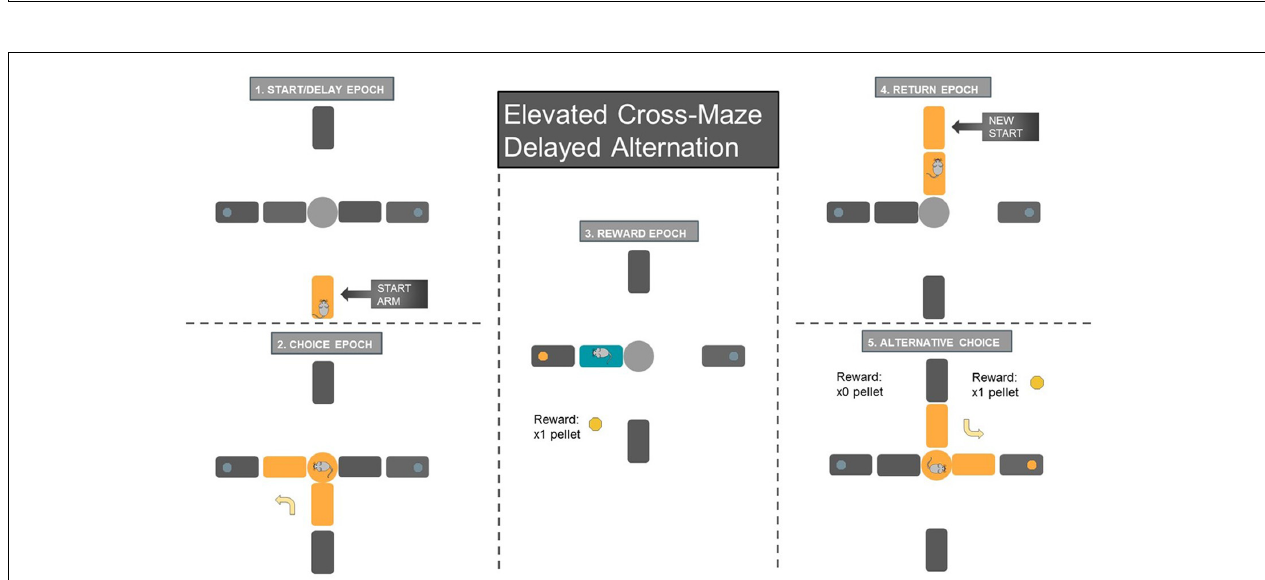
FIGURE 2 | Schematic of Delayed-Alternation Task. (1) Animals waited on the start arm for 10 s during the start/delay epoch. The arm segment closest to the center platform was lowered to confine the animal to the start arm region for the delay period. (2) The choice epoch started when the animal entered the center platform of the maze and made a choice to the left/right reward arm. The blue circle at the end of each reward arm signifies the metal cup where sugar pellets were delivered through food dispensers upon the animal’s arrival. (3) The reward epoch, which was analyzed only for the rewarded choice, while the other reward or start arm was lowered. Animals consumed the sugar pellet once they obtained the reward at the metal cup. (4) The return epoch began when the animal finished reward consumption and returned to the recently raised start arm (start arm location was pseudorandomized over the 60 choice trials). (5) Once the animal finishes the delay period, the next trial began. Only alternating choices were rewarded, while repeated entrance to the same reward arm resulted in no reward. After the animal returned to the start arm and waited for the 10 s delay period, a new trial began.